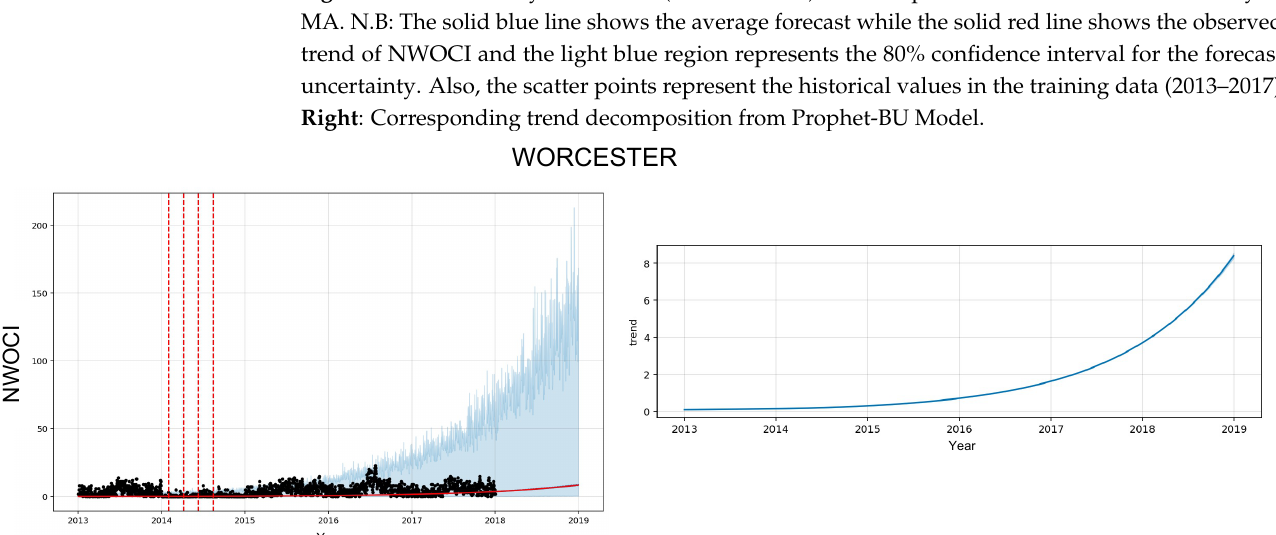
Figure A13. Left : One year forecast (2018 test data) from Prophet-BU Model for Worcester county in MA. N.B: The solid blue line shows the average forecast while the solid red line shows the observed trend of NWOCI and the light blue region represents the 80% confidence interval for the forecast uncertainty. Also, the scatter points represent the historical values in the training data (2013–2017). The red dotted lines show the time series change point delineated by the prophet model. Right : Corresponding trend decomposition from Prophet-BU